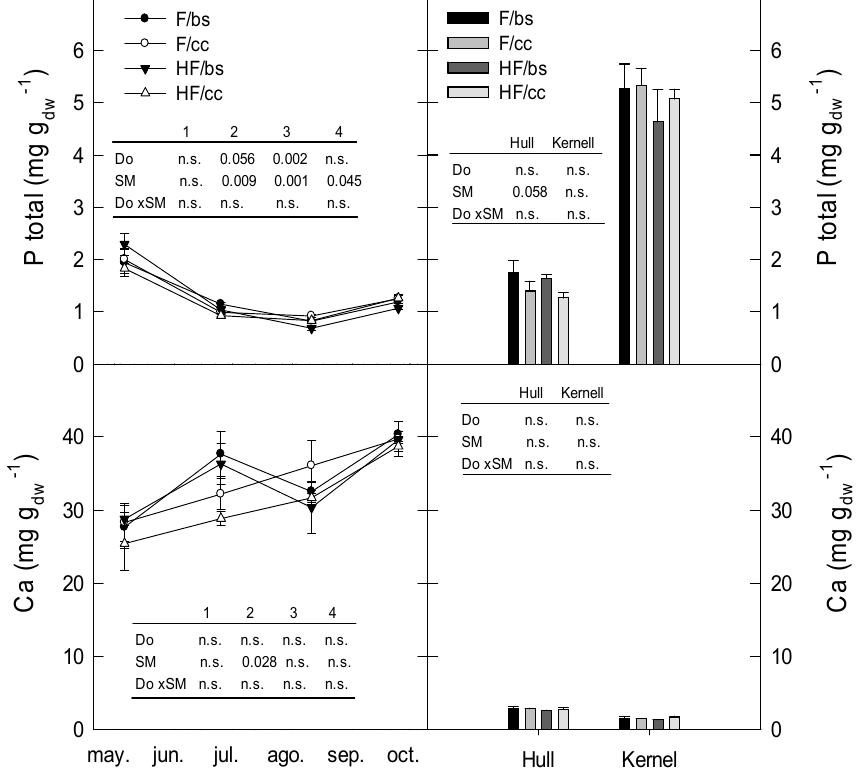
Figure 2. Effects of the fertigation dose (Do) (farmer (F) and half farmer (HF)) and soil management (SM) (bare soil (bs) and cover crops (cc)) and its interaction on the total P and Ca concentration in leaves, hull and kernel tissue in the 2020 season. Data shows the mean ± standard error. Numbers 1 to 4 indicated the leaf harvest sample date; 6 April, 25 June, 11 August and 25 September, respectively. N.s. means that the factor analyzed is not significant, and when significant the p -value is included. Leaf total N concentration tended to decrease until it reached a plateau between Au- gust and September, with no significant differences between treatments and without in- teraction between Do and SM (Supplemental Figure S1). Neither kernel nor hull N con- centration was affected by the treatments, the hull tissue being the one with the lowest N concentration. Contrary to total N, leaf N-NO 3 − concentration increased from June to Au- gust without significant differences among the treatments. The lowest value in the hull of N-NO 3 − concentration was recorded in F/CC treatment, but with no significant differences among the treatments. There were not differences in the leaf P-PO 43 − concentration in the different sampling dates; however, in the hull tissue, the CC treatments significantly re- duced the P-PO 43 − concentrations compared to the BS ones, with no effect on the kernel. Regarding potassium content evolution in the different tissues in 2020, it showed a tendency to decrease during the vegetative cycle, with no significant differences among the treatments or interaction between factors (Supplemental Figure S2). The highest K tis- sue concentration values were found in the hull and the lowest in the kernel. There was not an effect of the treatments on the Mg tissue concentration, being like the Ca, much lower in the hull and kernel than in the leaves. There was no effect of the treatments on the total S tissue concentration, finding the lowest tissue concentration in the hull.